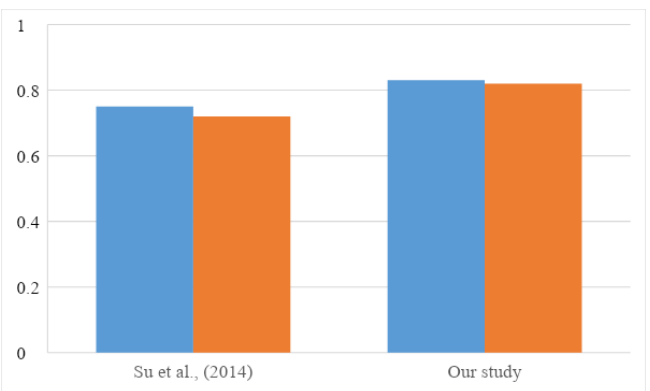
Figure 10. Comparison of model performances from Su et al. [23] and SVM model developed in this research.